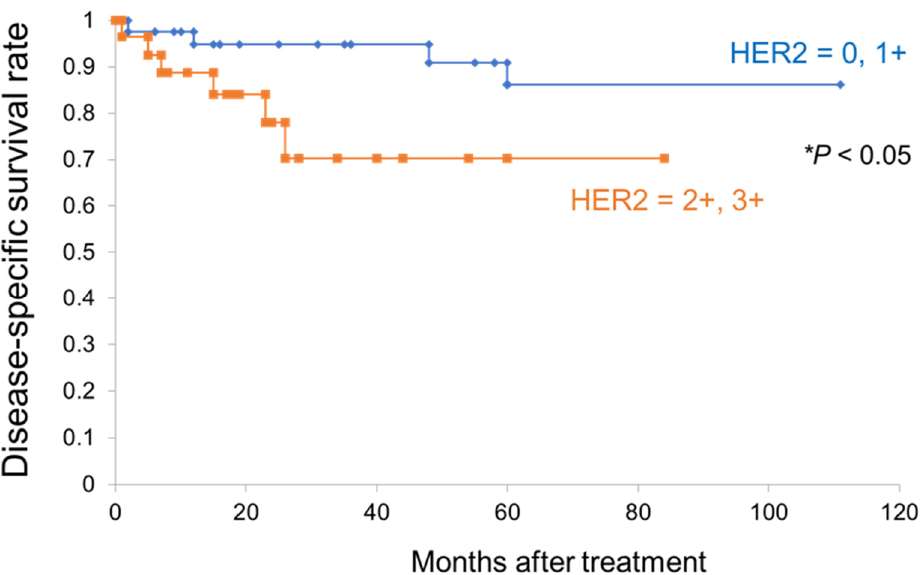
Figure 6. A significant correlation is observed between HER2-positive immunostaining and disease- specific survival. Kaplan–Meier curves to determine disease-specific survival for extramammary Paget’s disease patients are shown (blue: HER2-negative group (N = 51), orange: HER2-positive group (N = 28)) ( p = 0.045, log-rank test). Table 1. Clinical summary of the 79 EMPD patients.